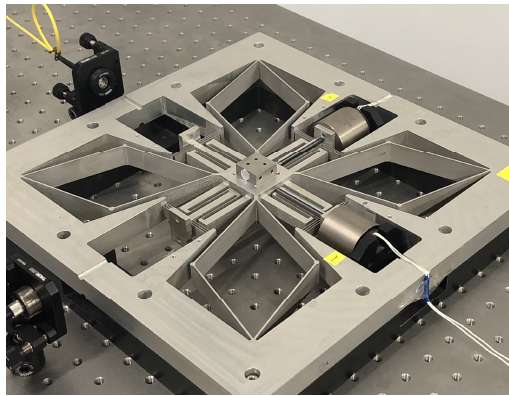
Figure 2. An XY compliant